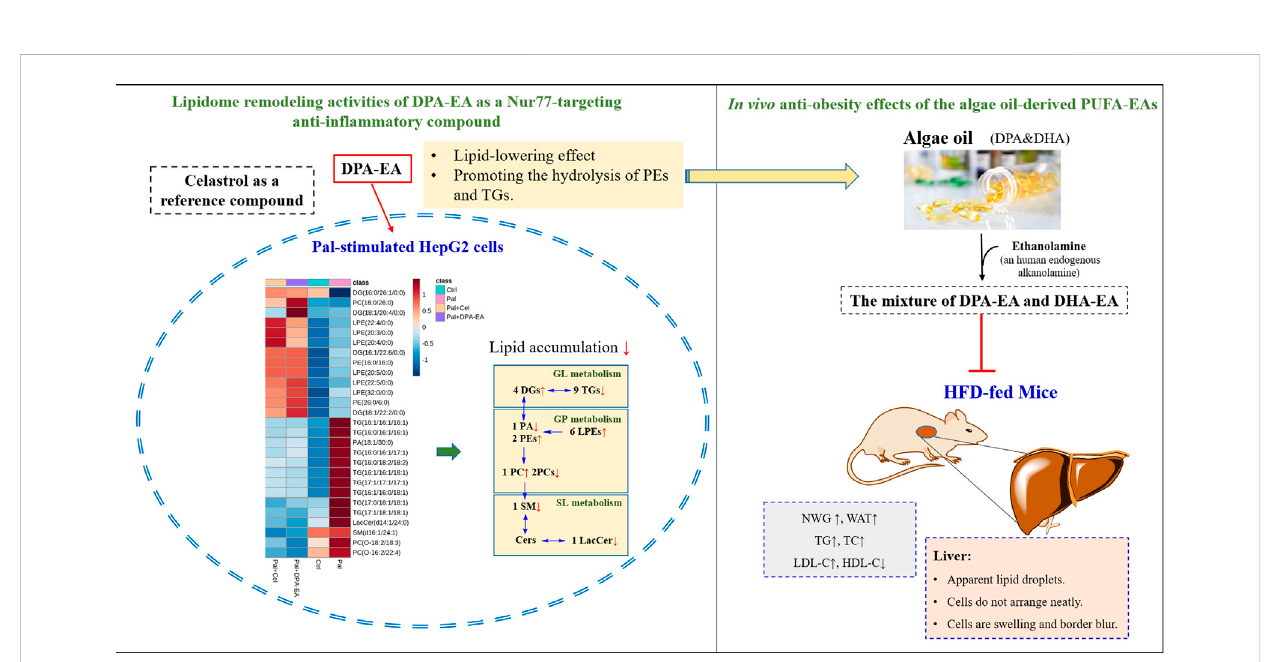
FIGURE 11 Lipidome remodeling activities of DPA-EA by targeting Nur77 and in vivo anti-obesity effects of the algae oil-derived PUFA-EAs.